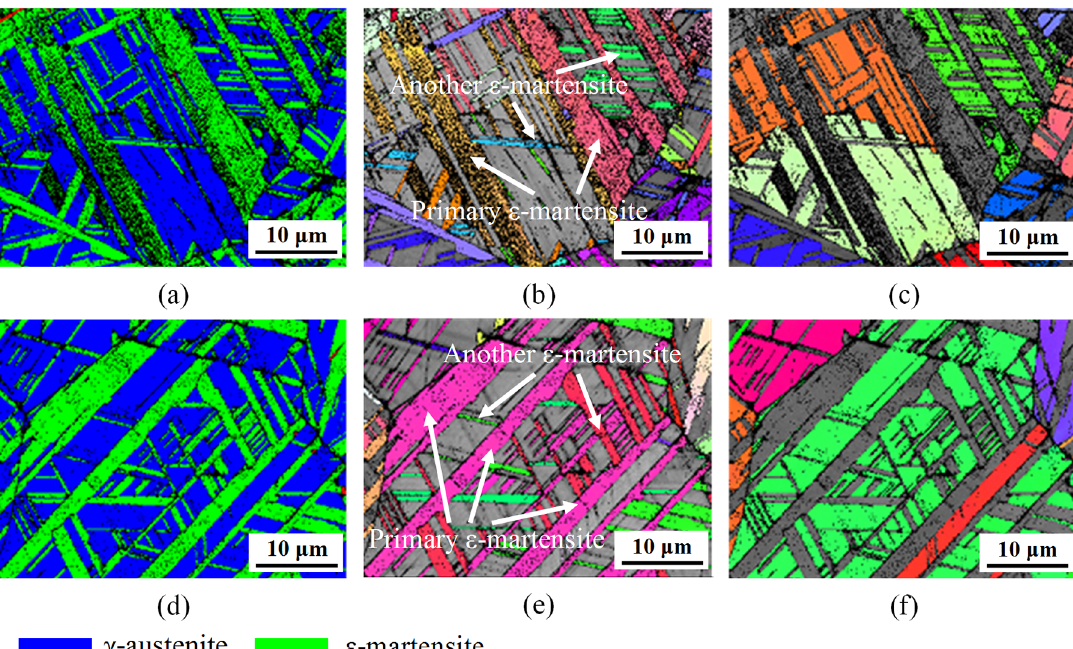
Figure 2. EBSD analyses on (a), (b) and (c) the Fe-19Mn alloy and (d), (e) and (f) the Fe-19Mn-8Cr-1Co-0.2Si alloy after solution treatment: (a) and (d) the phase maps; (b) and (e) the inverse pole figure maps of ε-martensite; (c) and (f) the inverse pole figure maps of austenite.